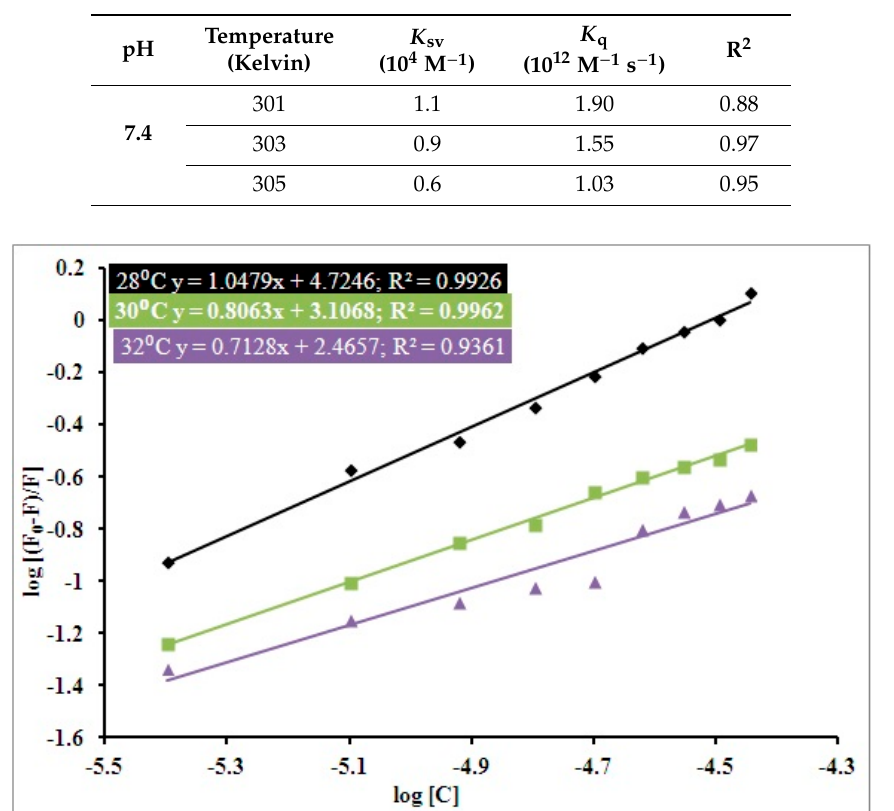
Figure 2. Double-log graphs (Modified Stern–Volmer plot) of the experimental fluorescence data for RT–hTf binding: The x -axis shows the log of concentration of quenchers while the y -axis depicts log F 0 − F/F.